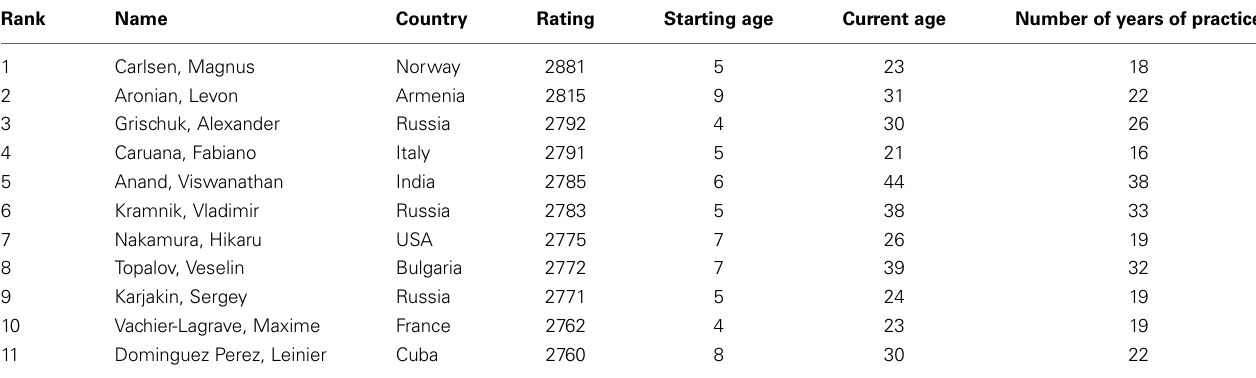
Table 1 | Rank, country, rating, starting age, current age, and number of years of practice of the 11 top players in the world (June 2014).